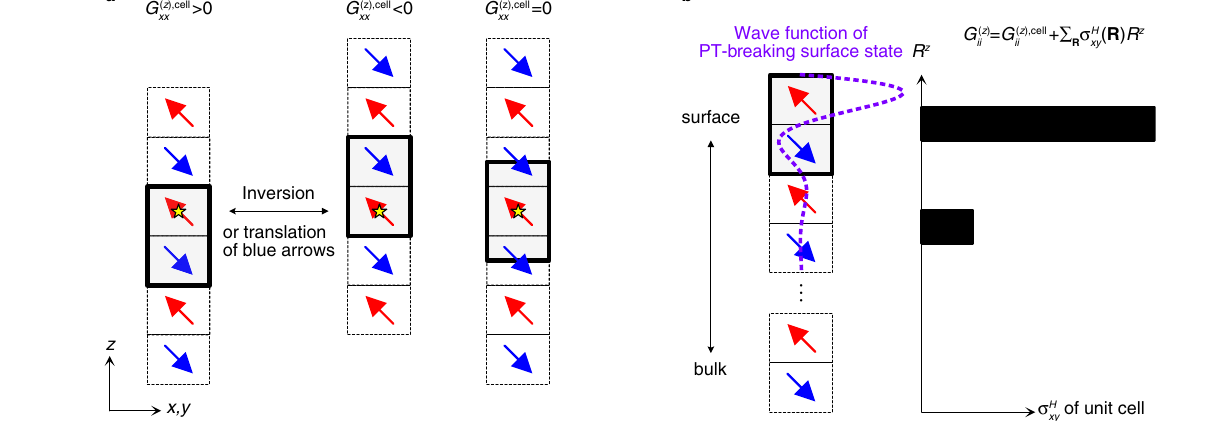
lattice constant if the deformation of the electronic states at the surface is neglected. The right-hand-side odd-layer system is inversion symmetric. The inversioncentersareshownasyellowstars. b Hallconductivityoftheunitcellinthe presence of surface states. The vertical displacement R z of a unit cell times its net Hall conductivity contributes to diagonal magneto-electric coupling G ð z Þ xx , G ð z Þ yy , and G ð z Þ zz